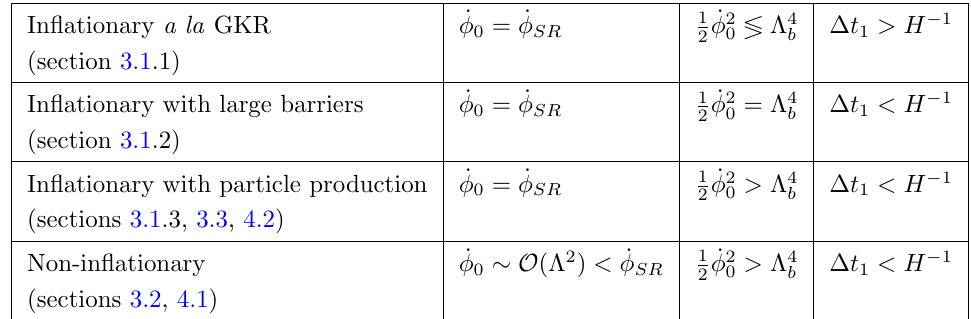
Table 1 . Comparison of relaxion models examined in this paper, in terms of the initial relaxion velocity compared to the slow-roll velocity, the initial kinetic energy compared to the (cid:12)nal potential barriers and the 1-period rolling time compared to the Hubble time. We stress that the choice _ (cid:30) 2 = 2 = (cid:3) 4 in the ‘large barrier’ case is not a tuning in the initial conditions, but rather a consequence 0 b of our a posteriori de(cid:12)nition of (cid:3) b as the amplitude of the barriers when the relaxion stops and the Higgs vev reaches its measured value (see the comments around eq. (3.1).